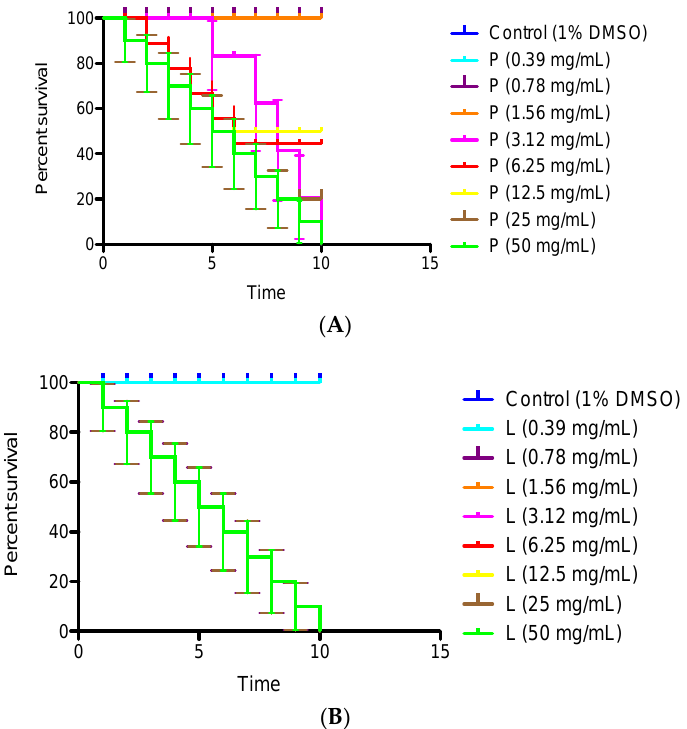
Figure 6. ( A ) Percent survival of P ( Peumo , C. alba ) and ( B ) L (Laurel , L. sempervirens ) EOs against C. elegans.